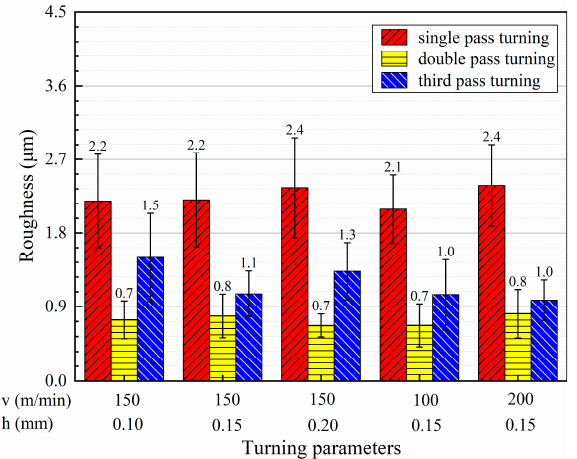
Figure 5. Average roughness of the machined surfaces under different turning conditions.